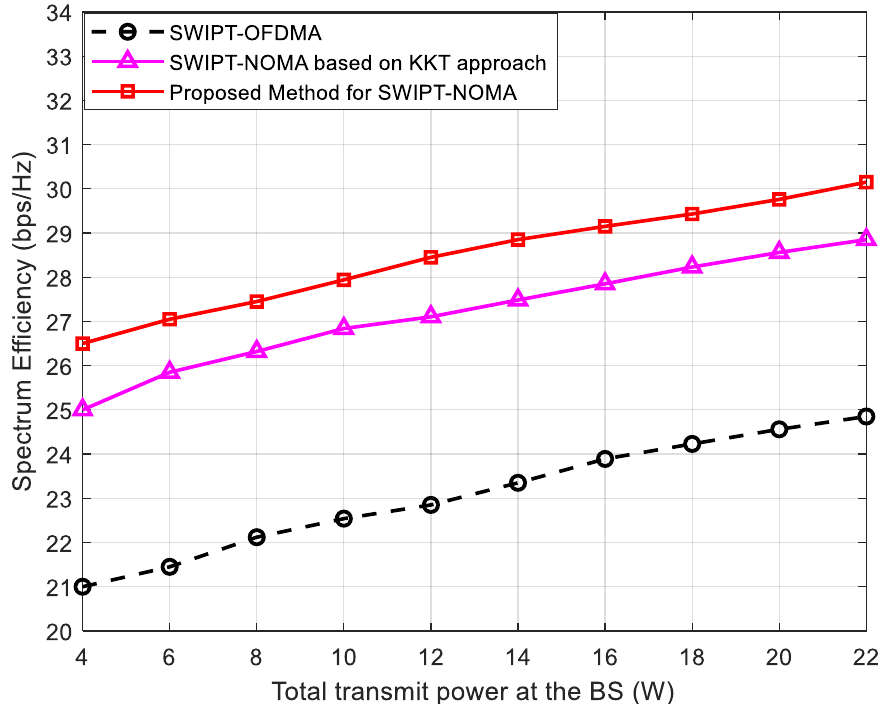
Figure 5. Spectrum efficiency versus total transmit power at the BS.